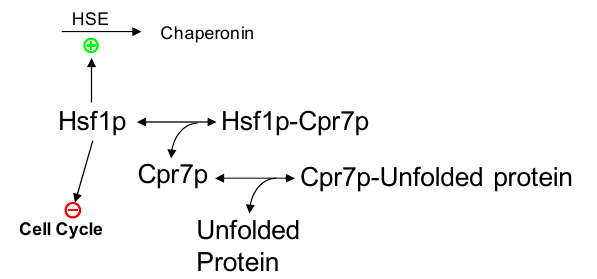
Figure 1. Modeling heat shock factor 1 (HSF1) activation. Free HSF1 protein binds to the heat shock element (HSE) and helps elicit the heat shock response, by inhibiting cell cycle progression and leading to the expression of chaperonins. In the absence of heat-unfolded proteins, the HSF1 protein is kept inactive by the CPR7 protein (Hsf1p-Cpr7p). Under heat stress, the CPR7 protein is sequestered by heat-unfolded proteins, thus releasing its inhibitory effect of HSF1.